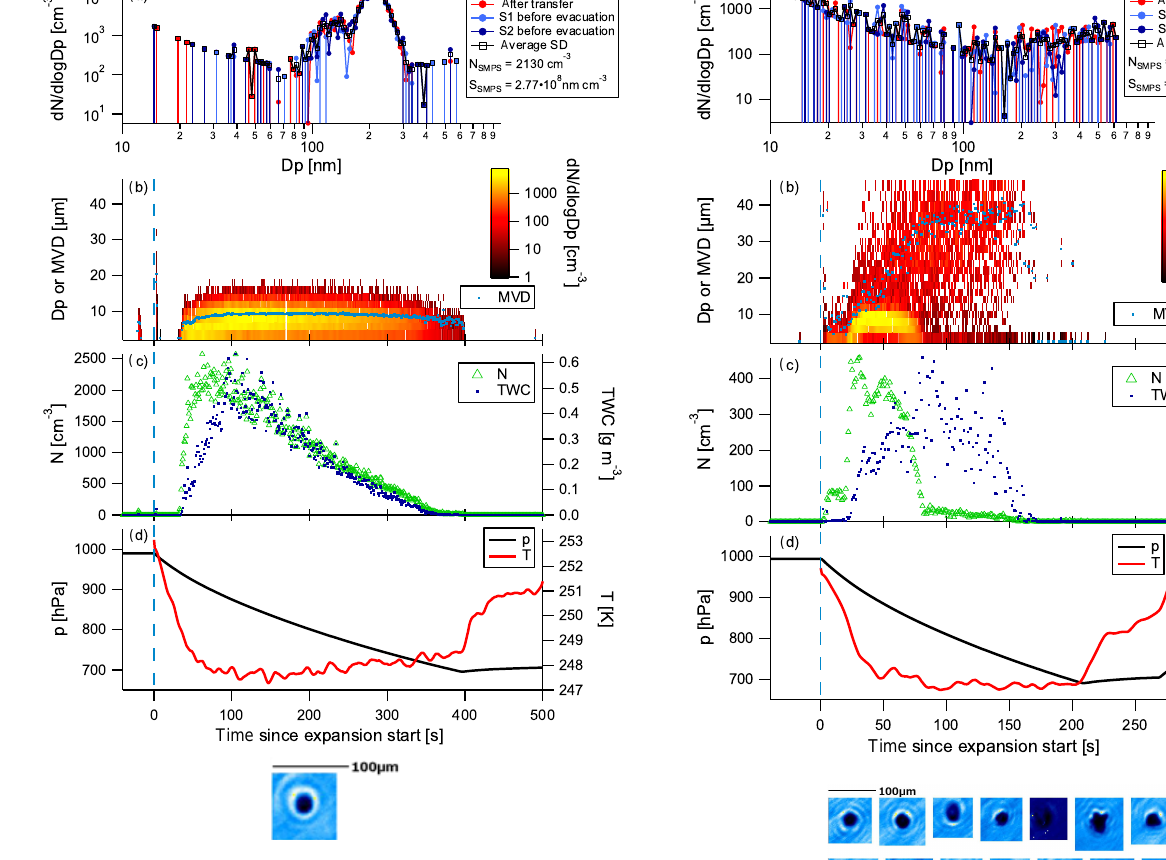
Figure 5. Same as Fig. 4 but using α -pinene as SOA precursor (ex- periment 8; see Table 1). This evacuation was the second run on the aerosol population, performed with a slow pump speed. Only one image was sampled by the CPI.